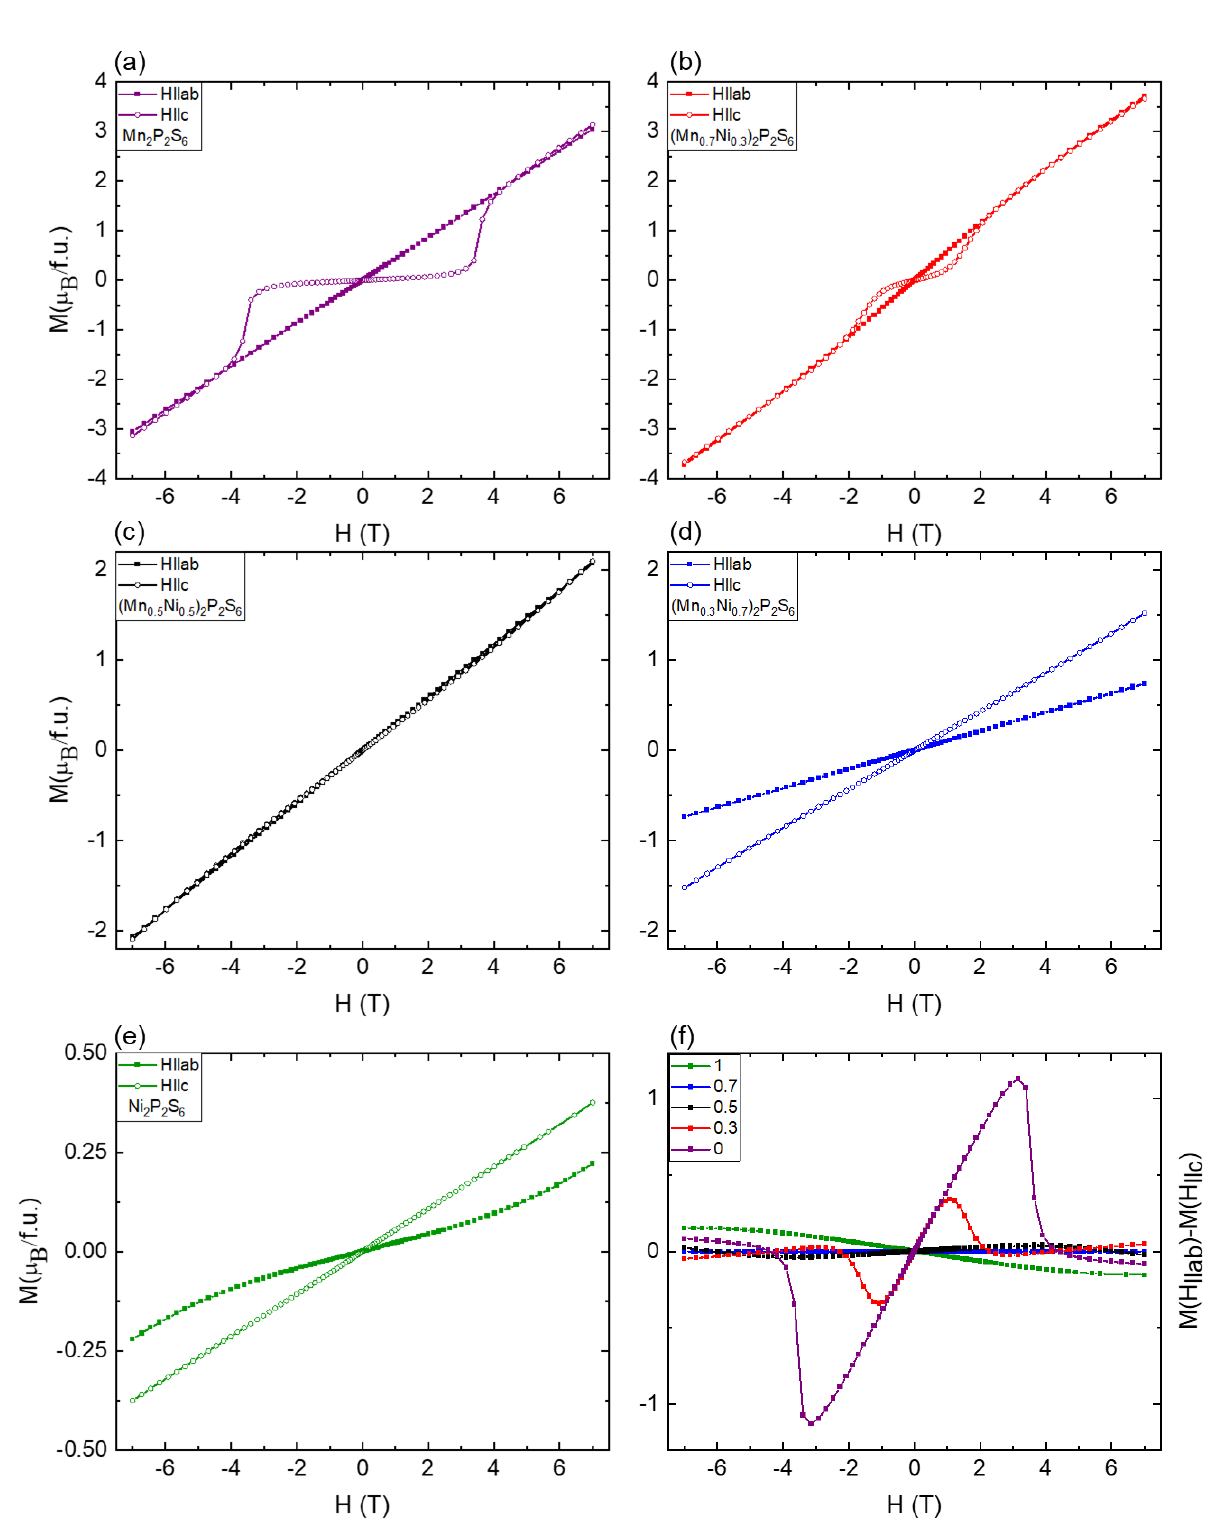
Figure 9. ( a – e ) Field dependent magnetization at 1.8 K for the full series (Mn 1−x Ni x ) 2 P 2 S 6 for a magnetic field applied along H || ab and H ||c . ( f ) The difference Δ M = M(H ||ab ) − M(H ||c ) is plotted as a function of magnetic field for all samples.